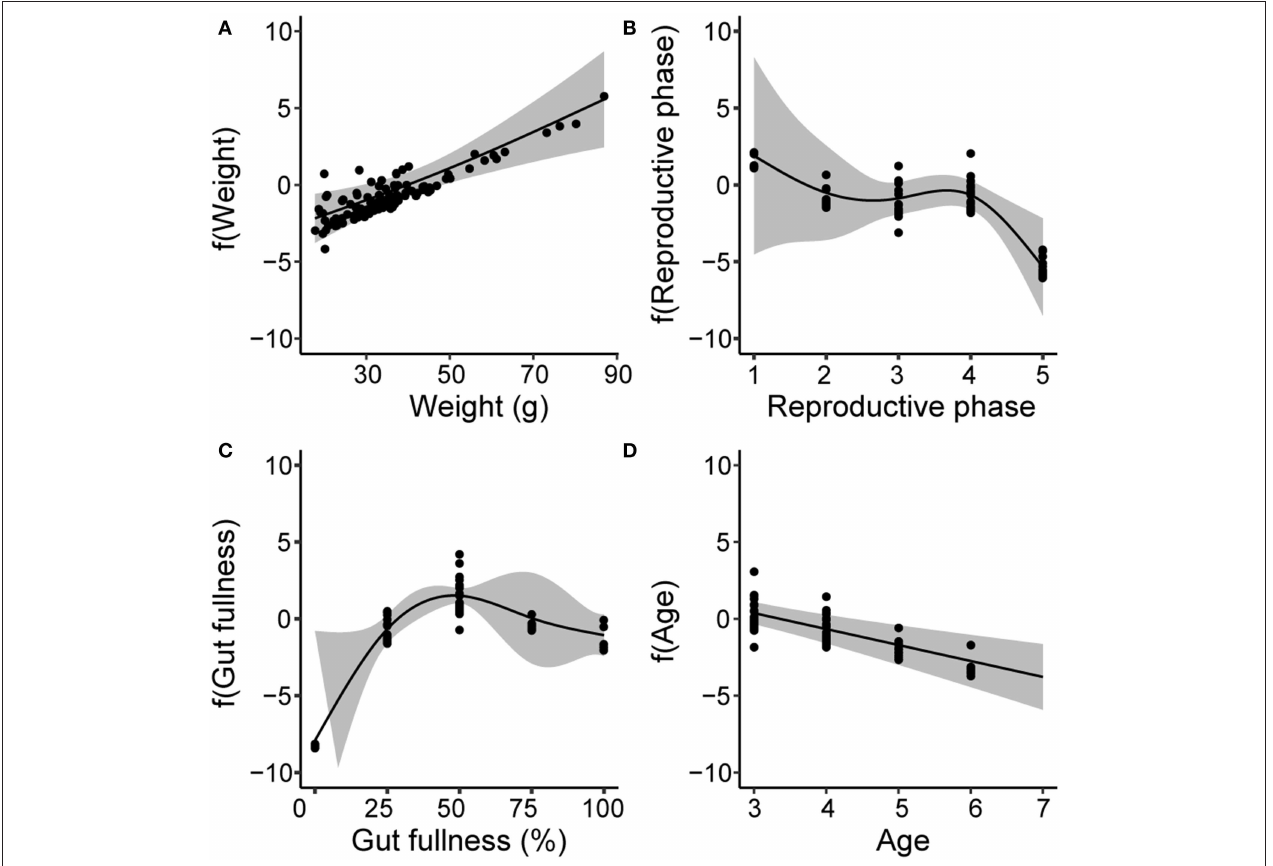
FIGURE 5 | Generalized additive models (GAMs) showing partial response curves for the explanatory biological variables: body weight (A) , reproductive phase (B) , gut fullness (C) and age (D) . The classes for reproductive phase correspond to: 1 = deformed gonads, 2 = post spawned, 3 = juvenile, 4 = developing gonads, and 5 = mature gonads. The vertical axis shows the relative influence of the explanatory variable on the prediction of MP burden on the base of partial residuals. Gray bands indicate 95% confidence interval for each